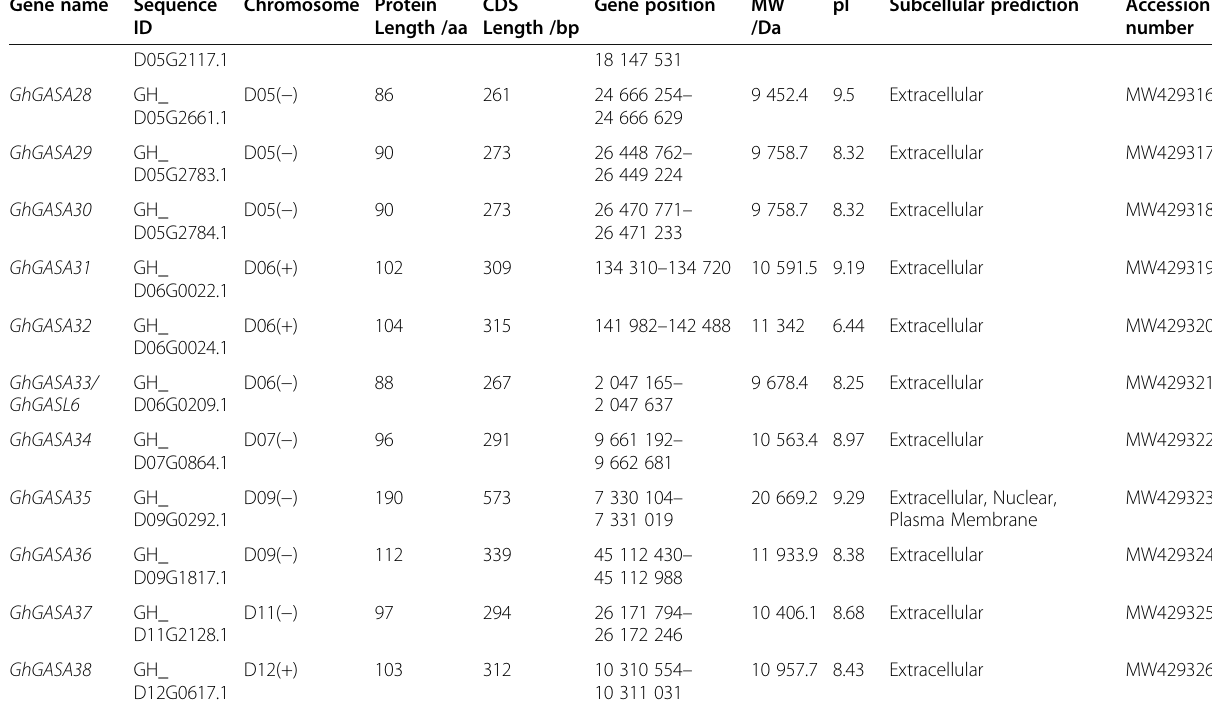
structures: an N-terminal signal peptide containing 18 to 30 amino acids, a variable peptide region, and